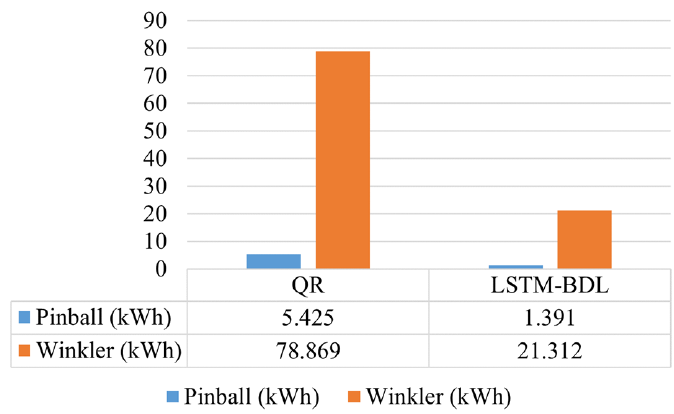
Figure 7. Probabilistic forecasting results for LSTM-BDL and QR.